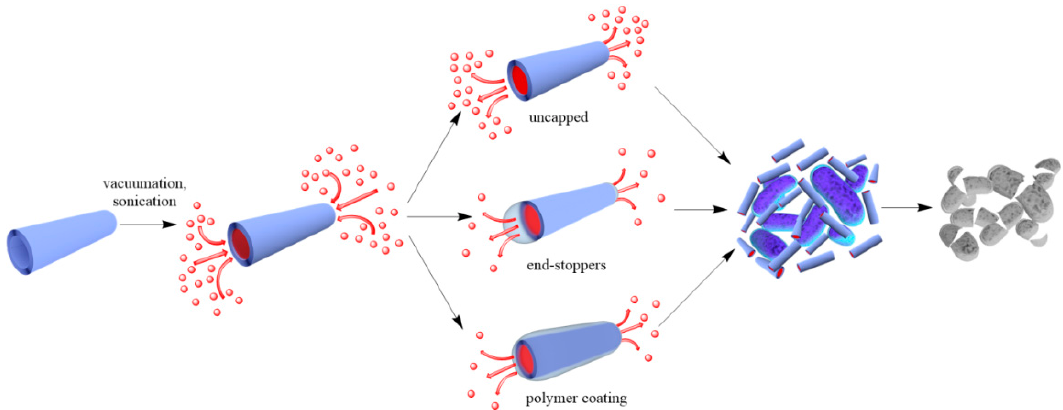
Figure 2. A scheme of antibacterial compound loading into halloysite lumens.